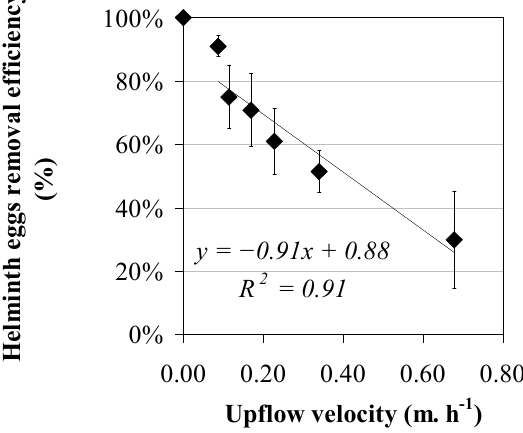
Figure 4. Helminth egg removal efficiencies ( ♦ ) versus upflow velocity using a sludge bed height between 0.50 and 0.60 m.